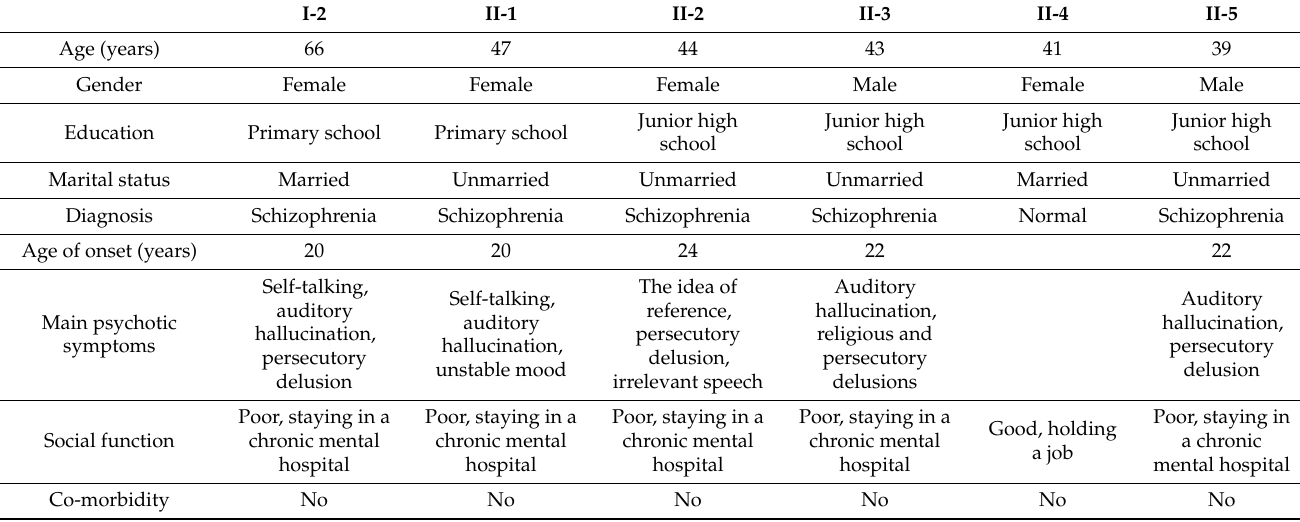
Figure 1. Pedigree of the two-generation multiplex family with schizophrenia. Table 1. Summary of socio-demographic data and disease-related data of the family in this